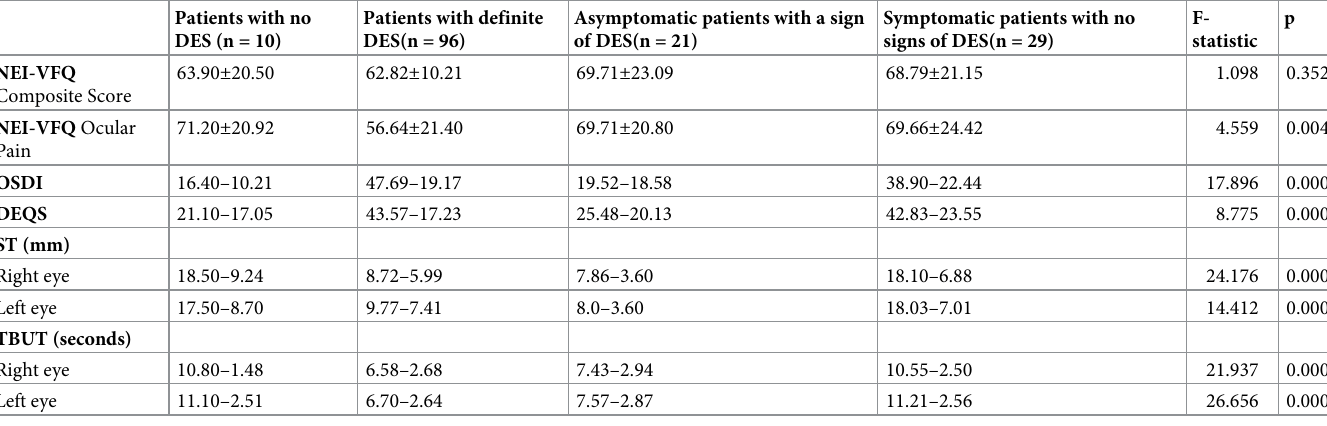
Table 4. Comparison of VFQ-25, OSDI, DEQS, ST and TBUT among the sub-groups. Patients with no Patients with definite Asymptomatic patients with a sign DES (n = 10) DES(n = 96) of DES(n =